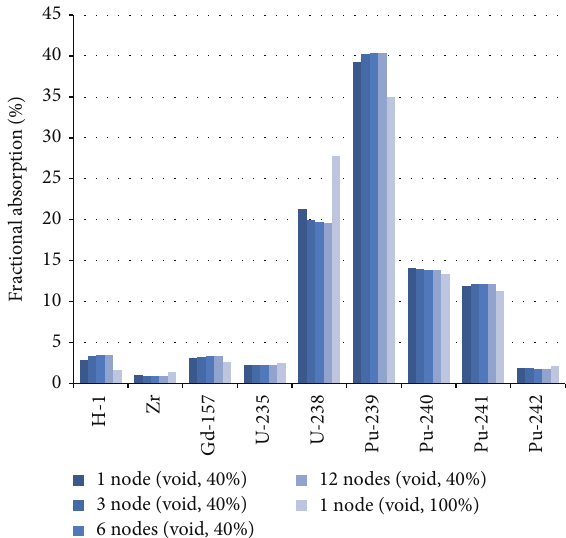
Figure 7: Isotopic fractional absorption.